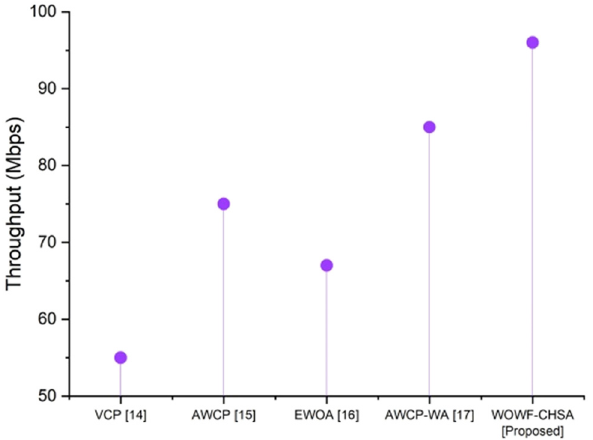
Figure 8: Results of proposed and existing methodologies for packet delivery